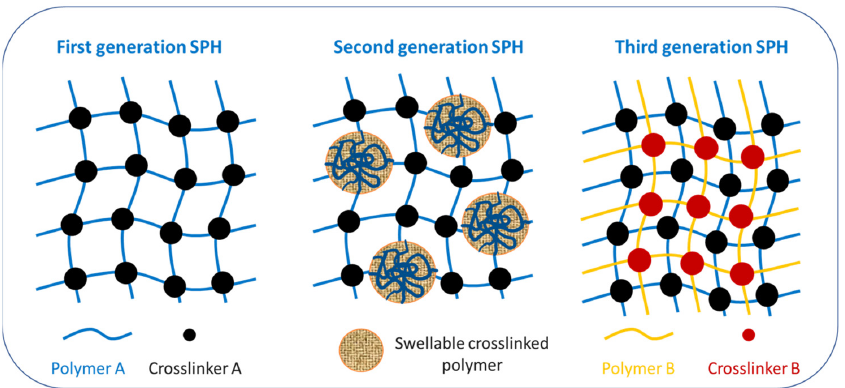
Figure 1. General scheme of the different types of super ‐ porous hydrogels. Today, up to three generations of SPHs are available for clinical use, but third ‐ gener ‐ ation SPH hybrids (SPHHs, also called super ‐ porous hydrogel interpenetrating networks or SPH ‐ IPNs) are preferred because they display better mechanical strength [17].